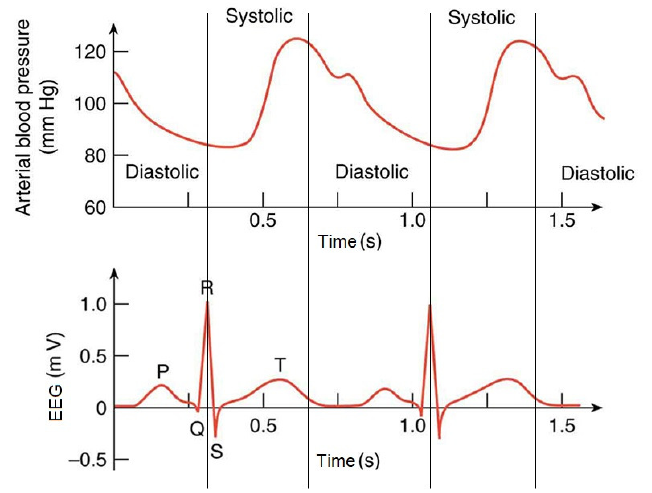
Figure 2. Blood pressure signal ( top ) and its corresponding ECG signal ( bottom